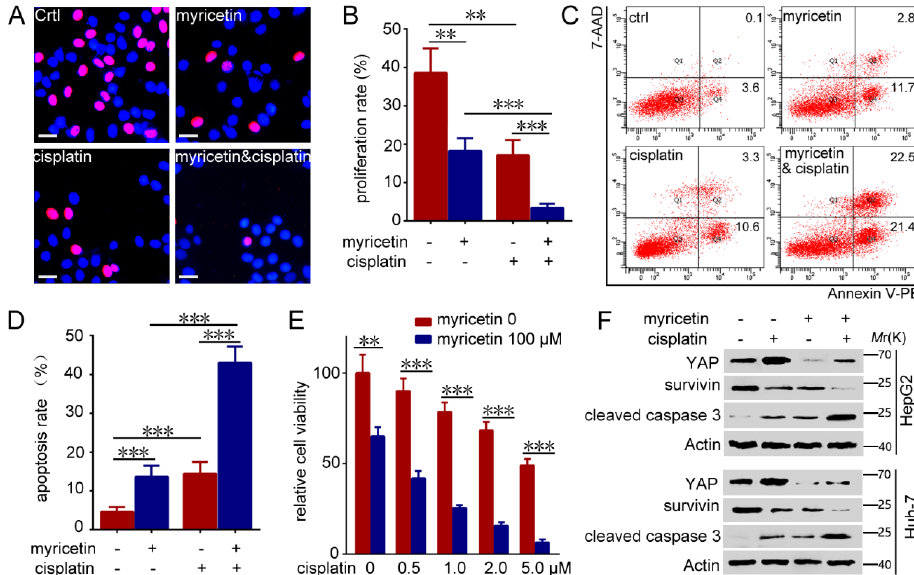
Figure 5. Myricetin sensitizes HCC cells to cisplatin by inducing degradation of YAP. ( A – D ) HCC cells were treated with or without 100 μM myricetin and 2 μM cisplatin for 48 h, followed by Hoechst and EdU labeling and flow cytometry analysis. ( A ) Representative images are shown. EdU-labeled (red) indicates proliferation of cells. Bar, 20 μΜ. ( B ) The proliferation rate is plotted. n = 4, ** p < 0.005; *** p < 0.001. ( C ) Representative scatter plots are shown. ( D ) The apoptosis percentage is plotted. n = 3, *** p < 0.001. ( E ) Huh-7 cells were treated with or without myricetin and cisplatin for 48 h. The cytotoxicity was assessed by CCK-8. The percentage of cell growth compared with control is plotted. Values represent the mean ± SD. n = 5, ** p < 0.005; *** p < 0.001. ( F ) HCC cells were